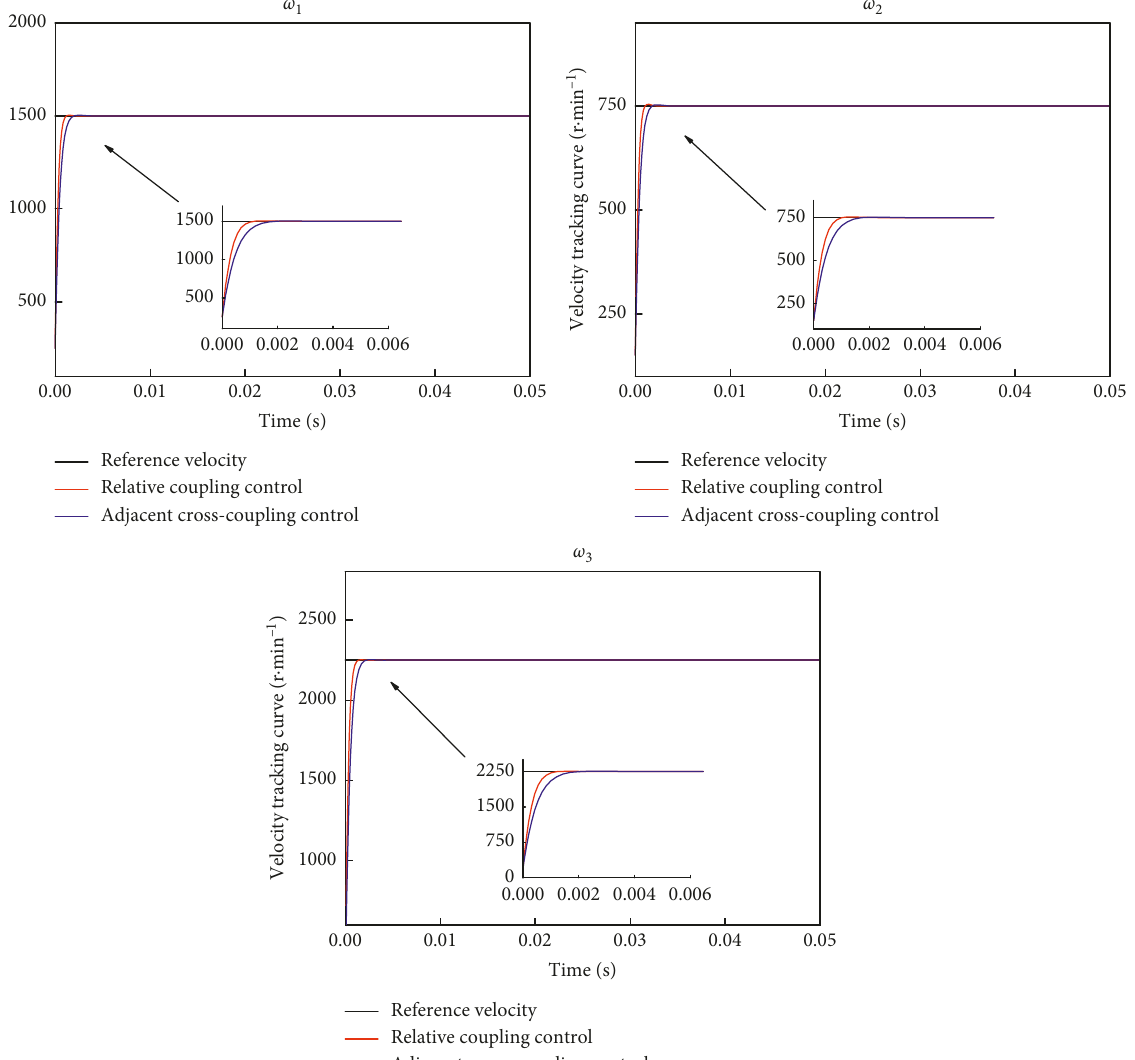
Figure 11: The velocity tracking curves of all servos under